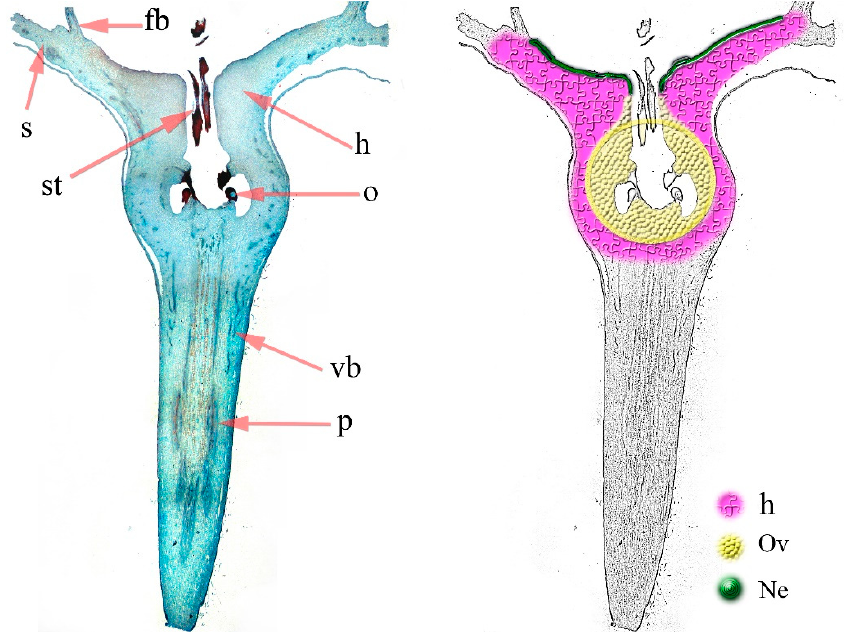
Figure 1. Longitudinal sections revealing the remaining parts of the reproductive structures and nectary contained within a flower of Kieffer cultivar ( left ). A comparative diagram of a longitudinal section of a flower’s receptacle showing a position of nectary (green) ( right ), ( × 2.5, LM).